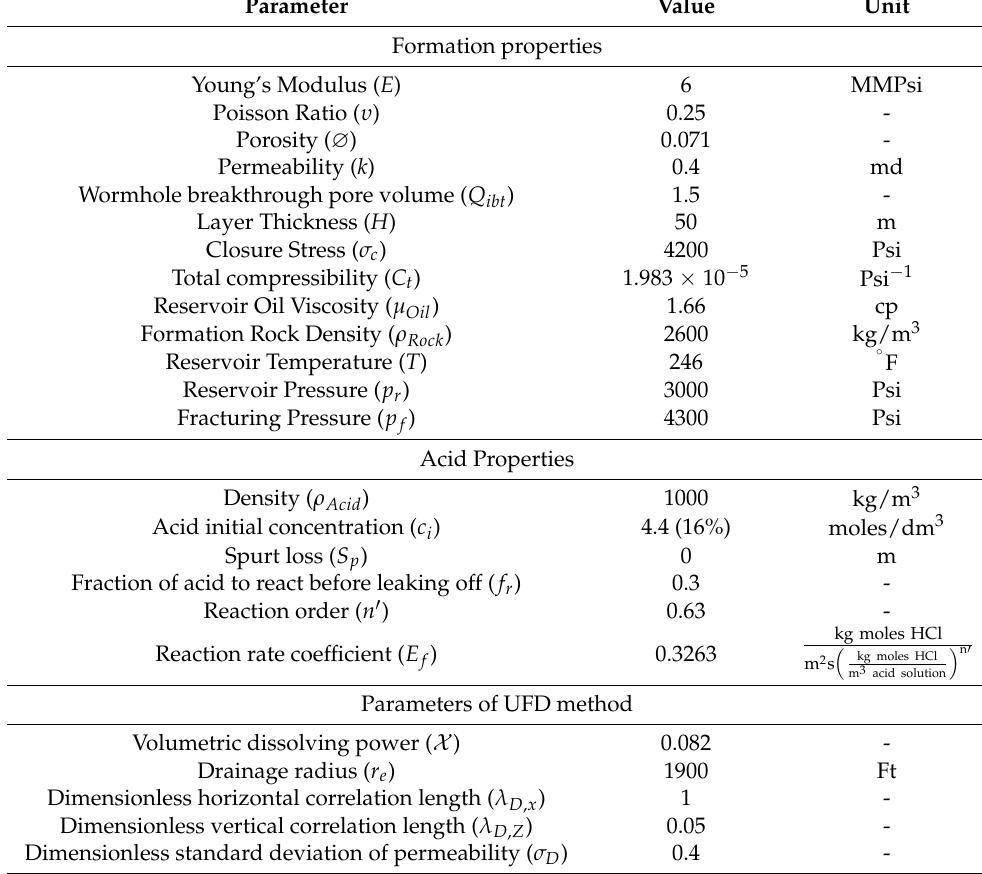
Table 1. Data required by the proposed